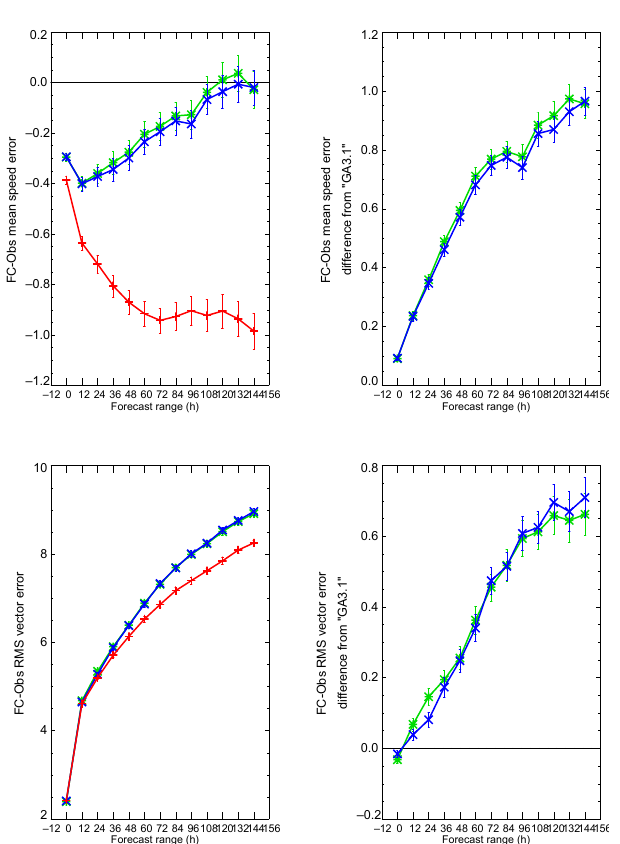
Figure 19. 250hPa tropical winds from the GA3.1 (red) and GA6.1 at N512 (blue) and N768 (green) compared with radiosondes: mean wind speed bias (top left), difference from GA3.1 (top right), RMS error (bottom left) and difference in RMS error (bottom